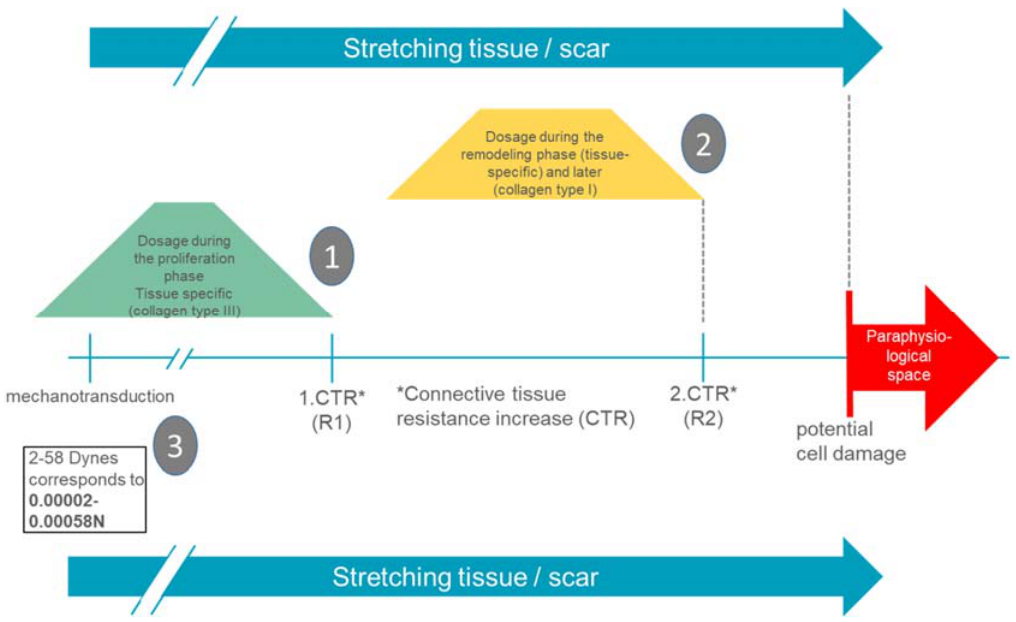
Figure 6. Summarizing presentation of wound ‐ healing ‐ phase ‐ adapted and tissue ‐ specific dosages in the manual therapy of burn scars (source: own presentation). Legend: (1). In the proliferation phase, in the area of the first remarkable increase in connective tissue resistance (amplitude). (2). In the remodulation phase, increasing until the second remarkable increase in connective tissue resistance (amplitude). (3). R1 and R2 are exemplary. Connective tissue displaceability in the back is located in a range of 1–4 N [28] (much higher than the fibroblast needs for mechanotransductive cell response).